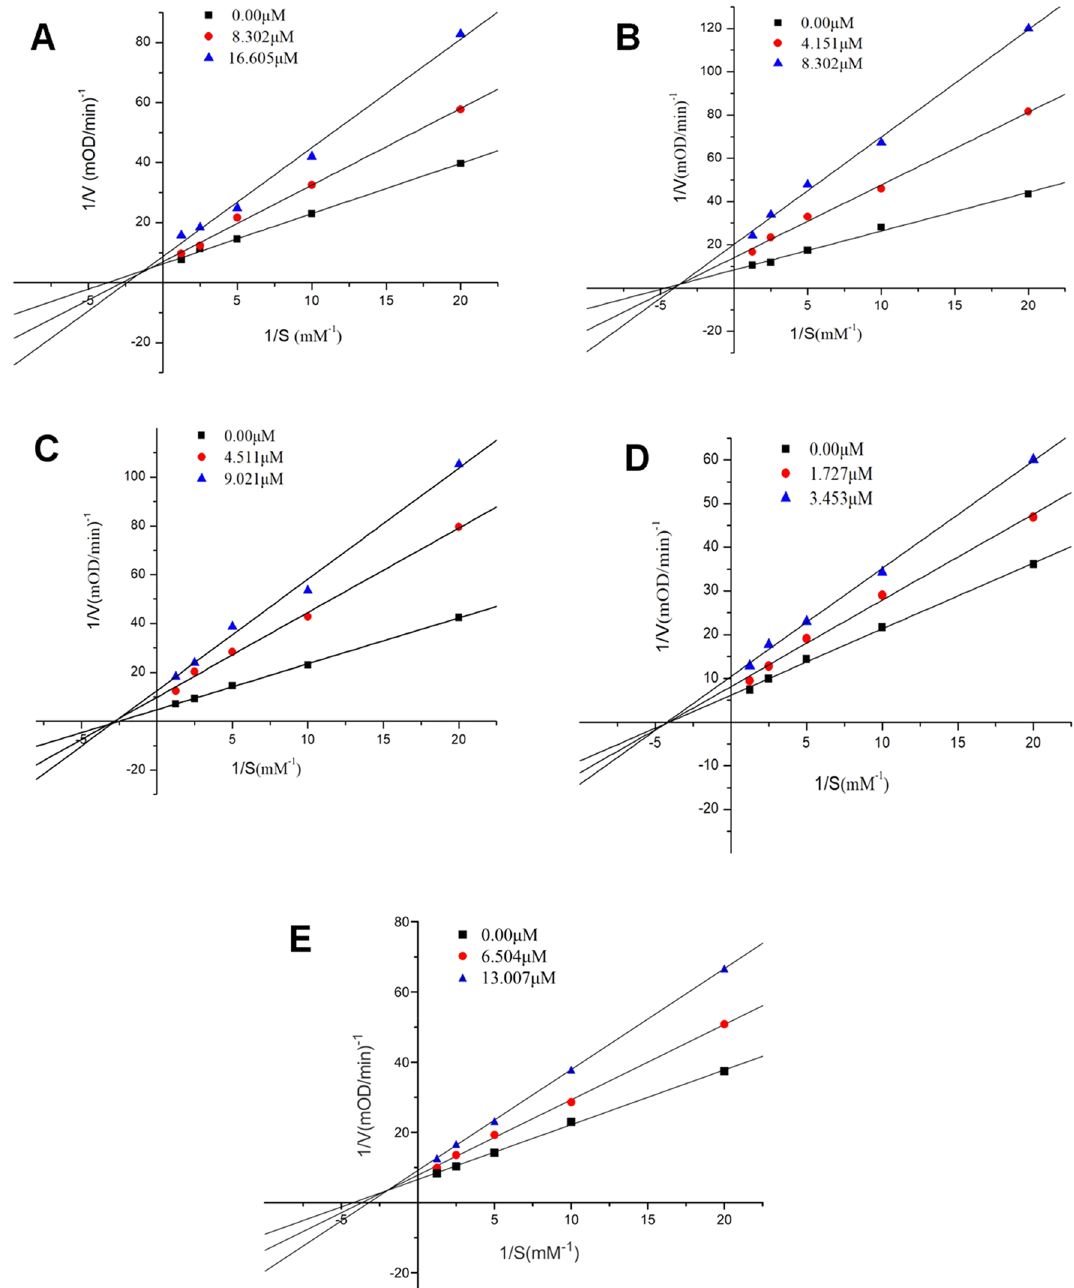
Figure 2. Lineweaver–Burk plots of five potent inhibitors against BChE. 6 ( A ), 8 ( B ), 10 ( C ), 12 ( D ) and 14 ( E ). ([S] concentration of indicated that the SASA of two complexes were attained increasing compared with individual BChE. Notably, the SASA of molecule 10 was significantly increased compared to the slight SASA increase of molecule 12 . This implied that the binding of 10 led to the opening of hydrophobic cavity of BChE, while 12 had little effect on the hydrophobicity of BChE. In silico ADME prediction. To evaluate drug-like properties of compounds, the ADME (absorption, distri- bution, metabolism and excretion) properties of five inhibitors were predicted in silico using the QikProp v. 5.5 (Schrödinger). As showed in Table 2, five molecules performed well in the matter of acceptable absorption per- centage, polar surface area, hydrogen bond acceptor/donor and oral bioavailability. It is important to consider that CNS (central nervous system) drugs usually exhibit low molecular weights (MWs), usually in the range of 400–600 Da or below. Marketed CNS-acting drugs have been reported to show a mean MW of 310 Da 32 . In the present study, all five inhibitors presented MWs within the established intervals. QPlogP o/w predicts the water